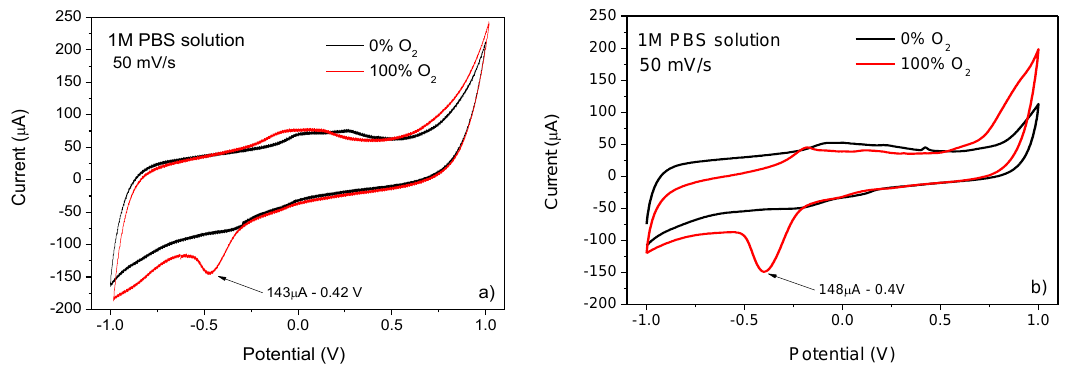
Figure 4. Cyclic voltammograms obtained in presence of different oxygen concentration and recorded in the potential range from −1 to 1 V at a scan rate of 50 mV/s on: ( a ) home-made manufactured portable analyzer; ( b ) commercial one.